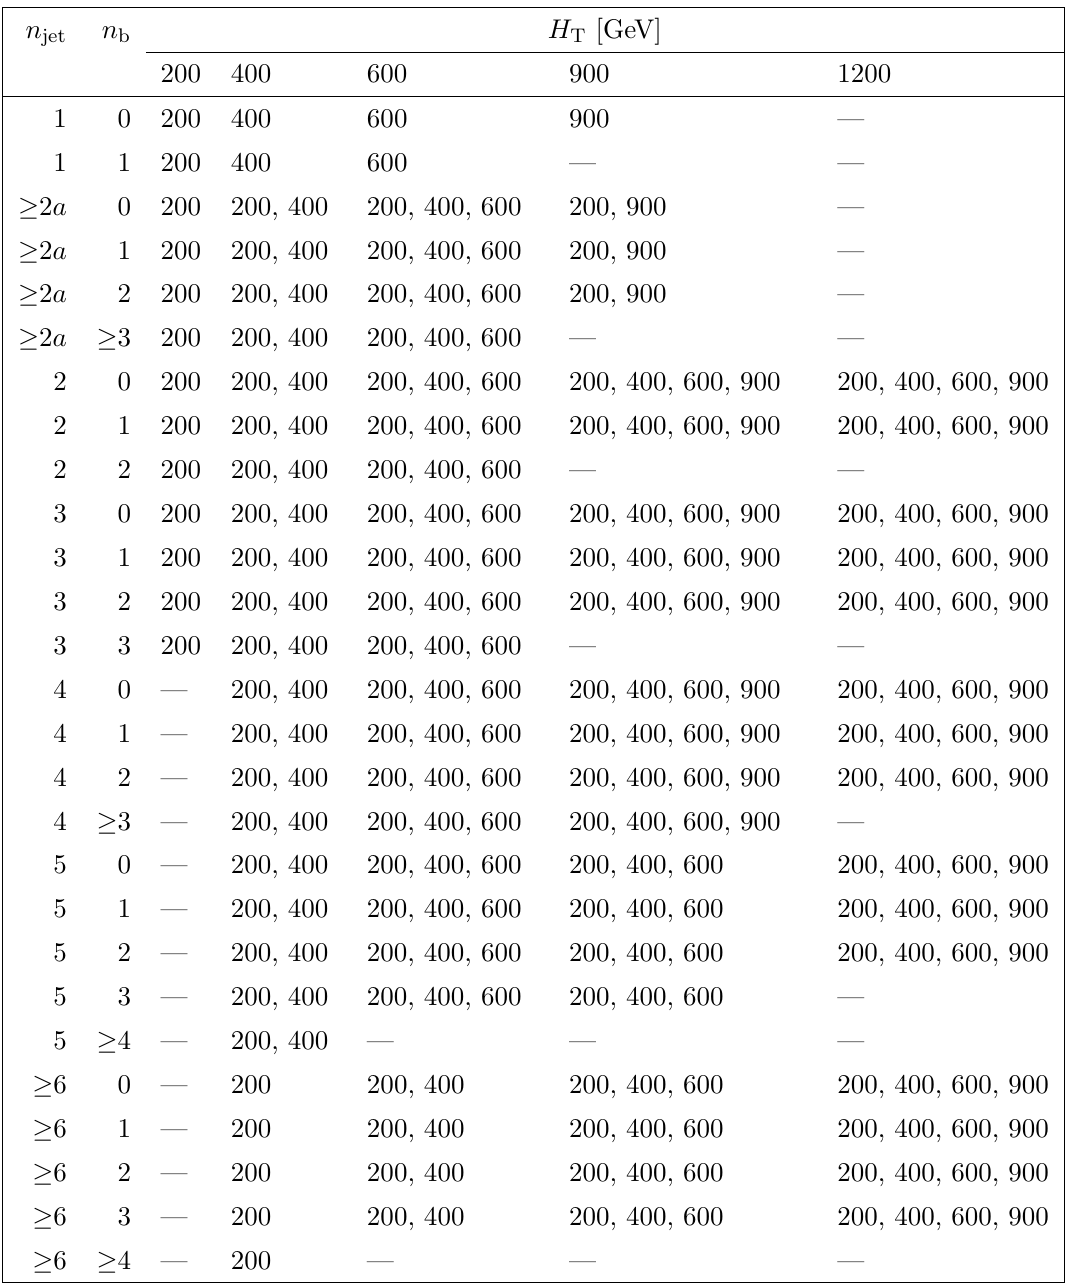
Table 6 . Summary of the nominal ( n jet , n b , H T , H miss following entry, if present) signi(cid:12)es the lower (upper) bound of an H miss H T ) bin. Unique or (cid:12)nal entries represent H miss that the H T bin in a given ( n jet , n b ) category is not used in the analysis, in which case counts in high- H T bins are integrated into the adjacent lower- H T bin. For monojet events, H T (cid:17) H miss a denotes asymmetric p T thresholds for the two highest p T